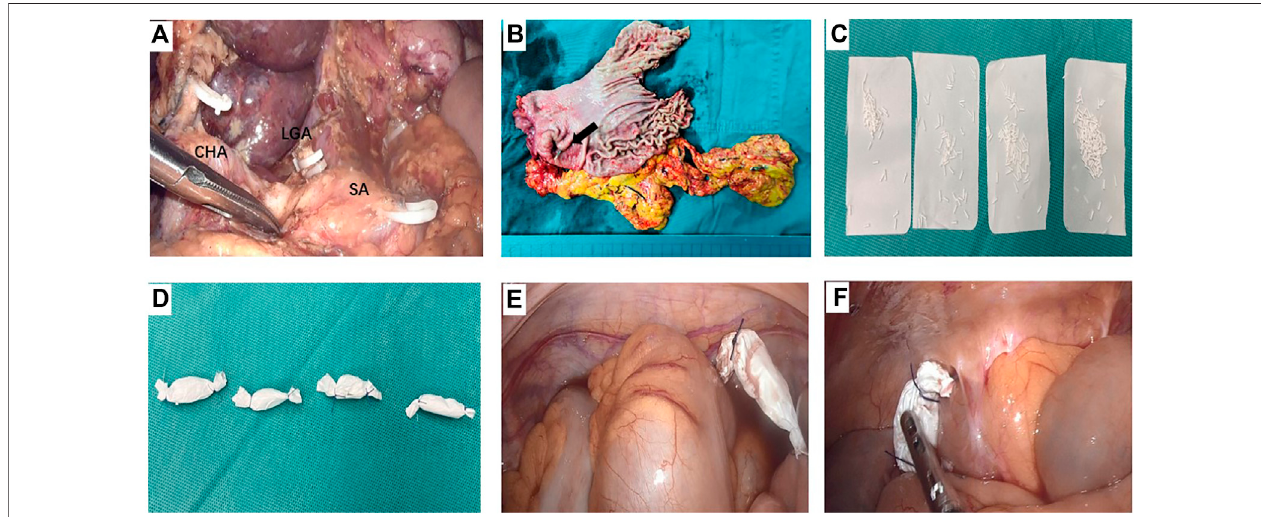
FIGURE1| Arepresentativecasewhoreceived5- fl uorouracil(5-FU)implantsduringoperation (A) Theoperation fi eldoflaparoscopicdistantgastrectomy afterD2 dissection. The three branchesof the celiactrunk were exposed, i.e. splenic artery(SA), common hepatic artery (CHA), and the stump ofleft gastric artery (LGA) (B) The surgical specimen of gastric cancer located in the antrum (black arrow) (C) and (D) 800 mg 5-FU implants were divided into 4 parts and were packed by absorbable gauze (E) One pack of 5-FU implants was placed in the pelvic cavity (F) One pack of 5-FU implants was placed in the right paracolic sulci.